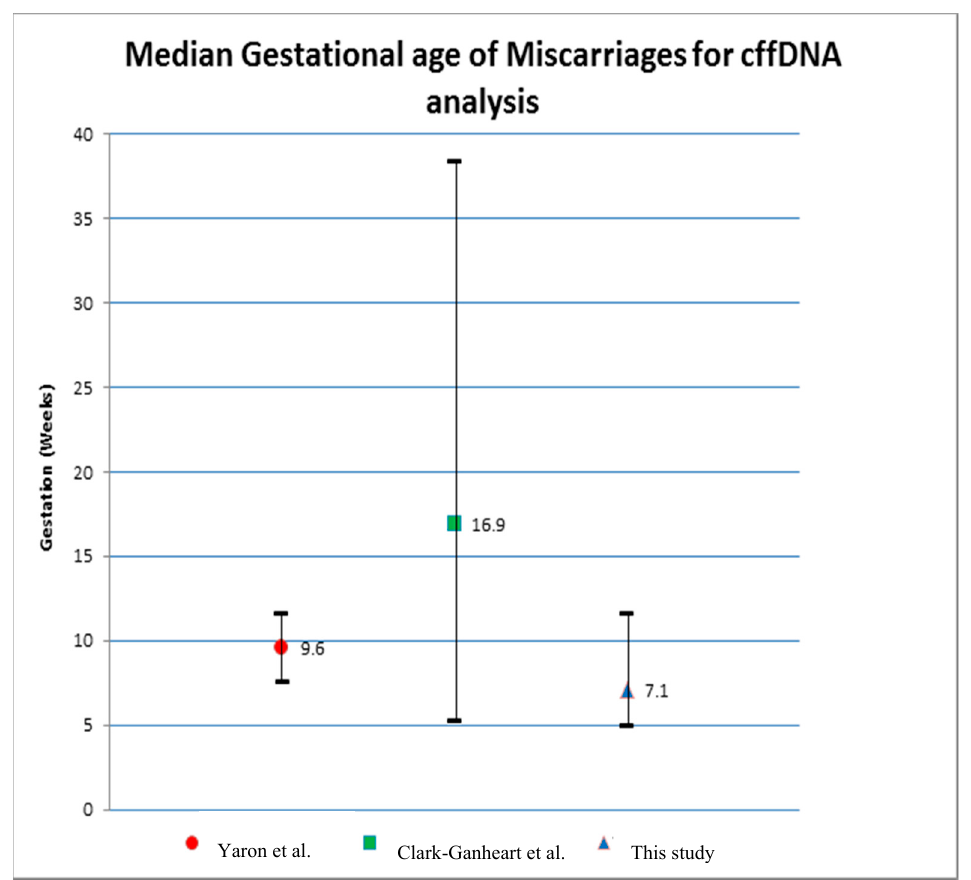
Figure 2. Gestations of pregnancy loss by ultrasound scan [6,7].